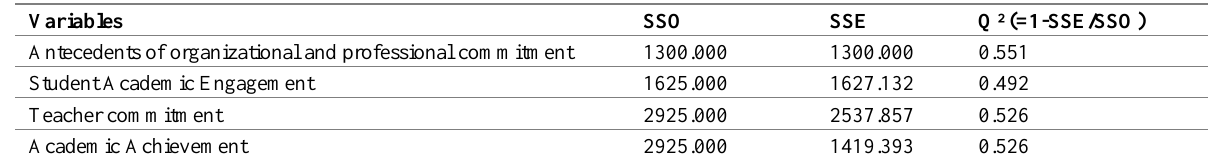
Table 8: Predictive validity of the model